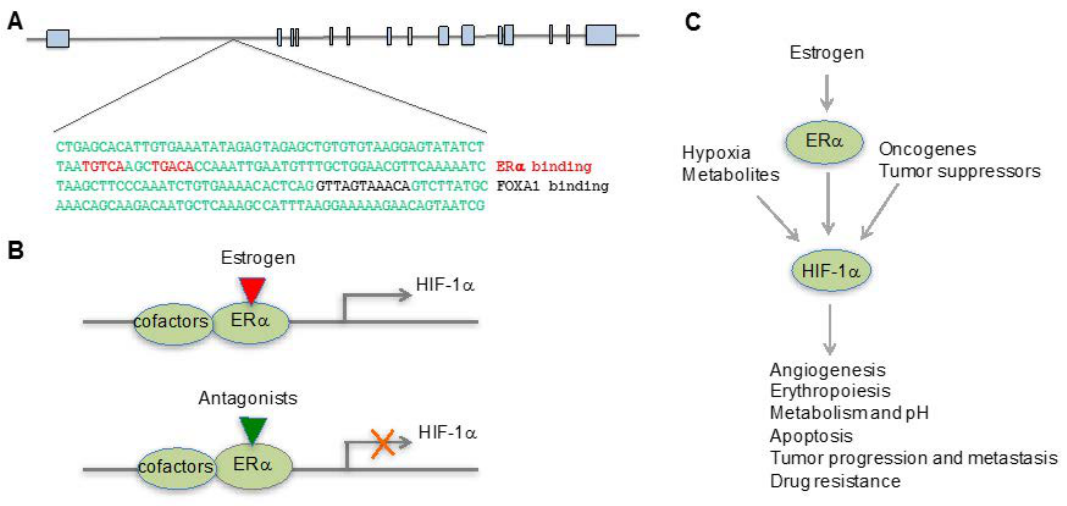
Figure 1. Estrogen pathway directly drives HIF-1 α expression. ( A ) HIF-1 α gene bears a canonical estrogen receptor binding element (ERE), with a FOXA1 binding site downstream of ERE; ( B ) When ER α is bound by its ligand it drives the expression of HIF-1 α . However, ER α antagonists block the expression of HIF-1 α ; ( C ) The pathways mediated by hypoxia, estrogen, metabolites, and cancer genes converge on HIF-1 α , which drives a plethora of genes that are involved in multiple biological processes, cancer progression, and therapeutic